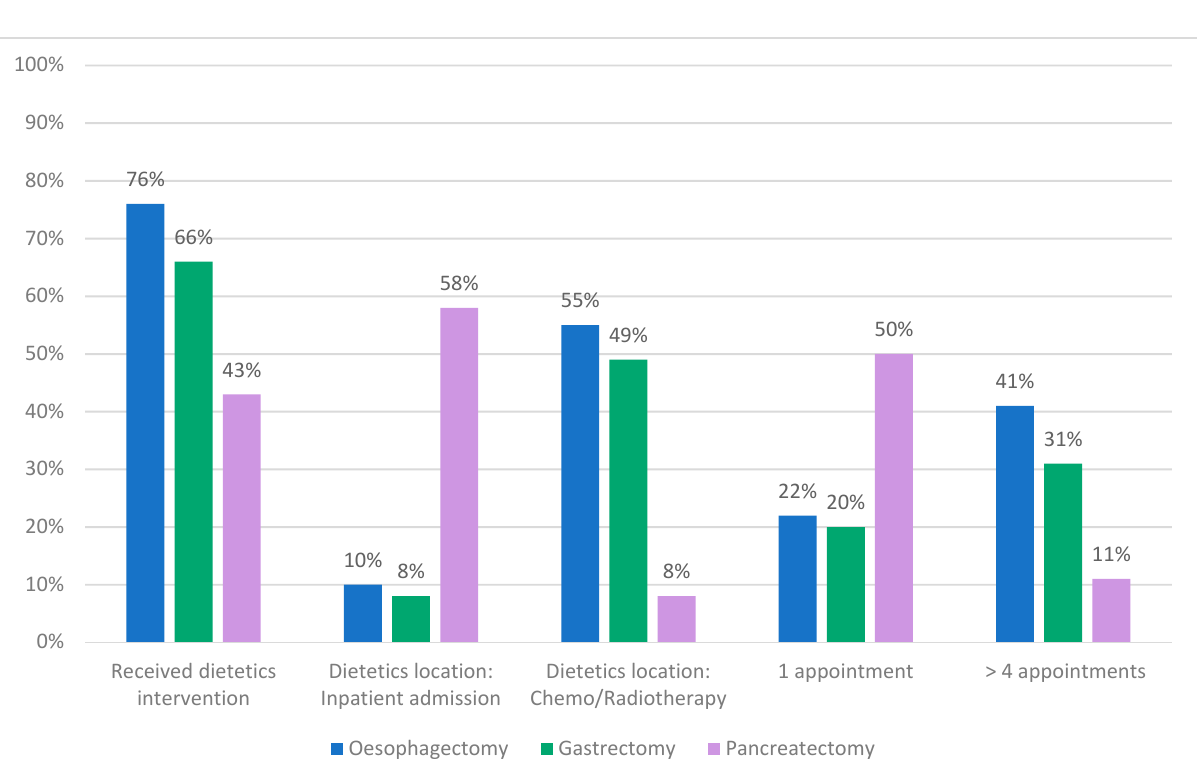
Figure 1. Location of dietetics service ( n = 119). UGI, upper gastrointestinal.